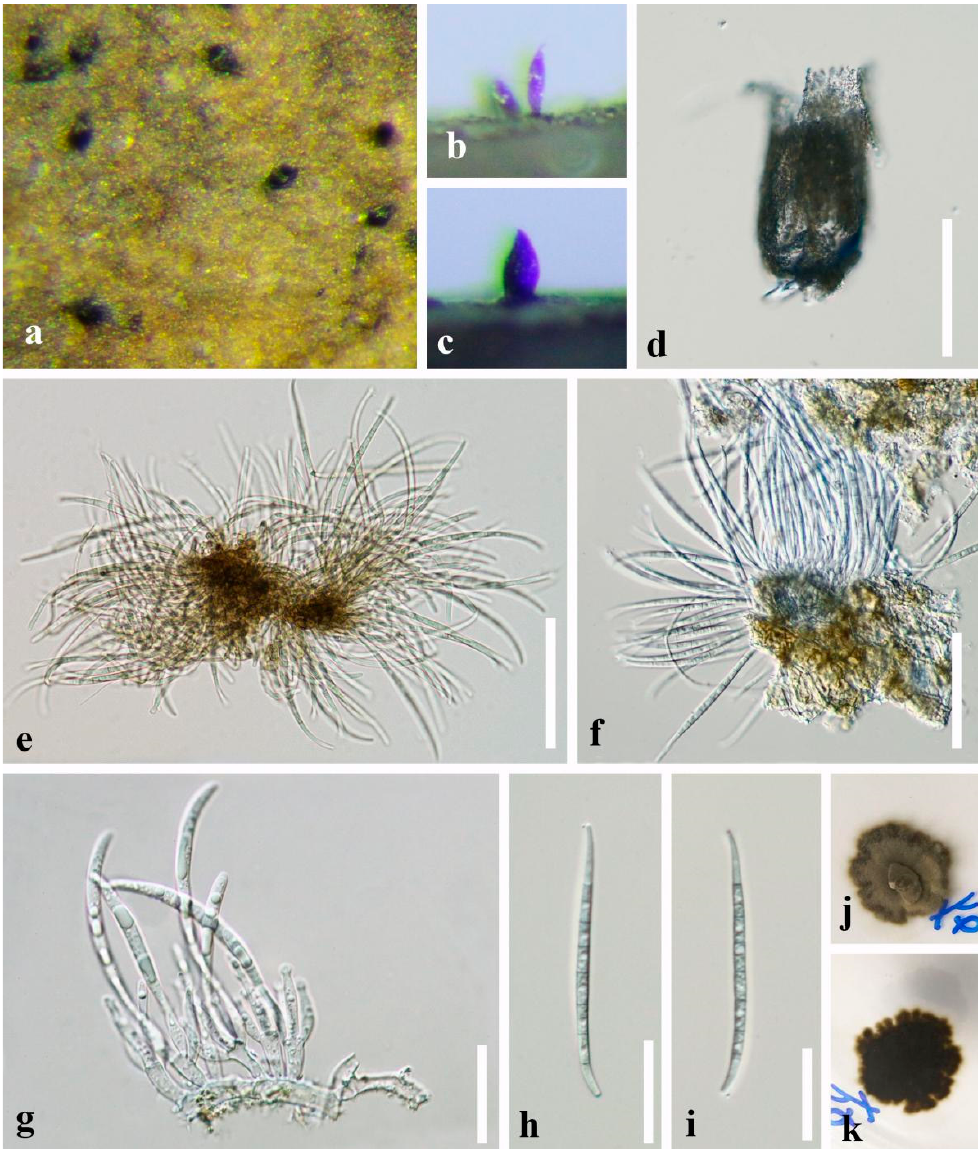
Figure 4. Pseudocorniculariella guizhouensis (GZAAS20-0408, holotype ) ( a – c ) Conidiomata on wood. ( d ) Pycnidium. ( e – g ) Conidiogenous cells and conidia. ( h , i ) Conidia. ( j , k ) Culture, j from above, k from below. Scale bars: ( d ) =100 μ m, ( e , f ) =50 μ m, ( g – i ) =25 μ m.